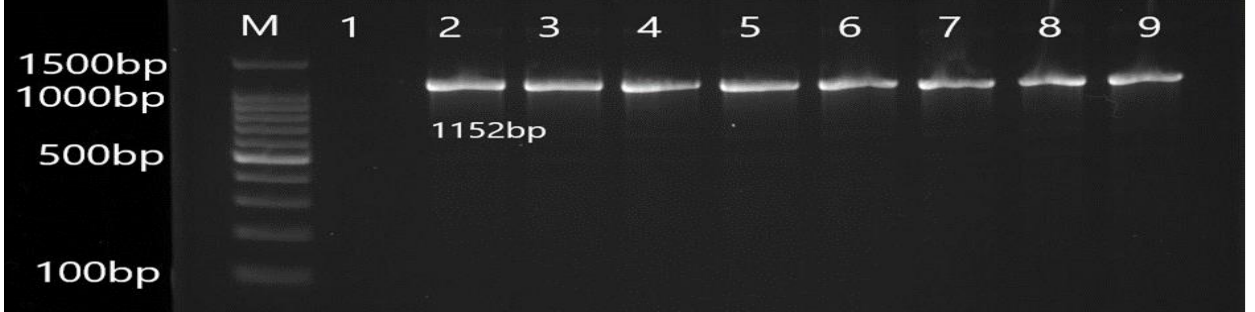
Figure 2. Electrophoresis showing amplicons of P. aeruginosa mexA gene. Lane M: 100 bp molecular marker, Lane 1: Negative control, Lane 2 – 9: Positive isolates of mexA gene.